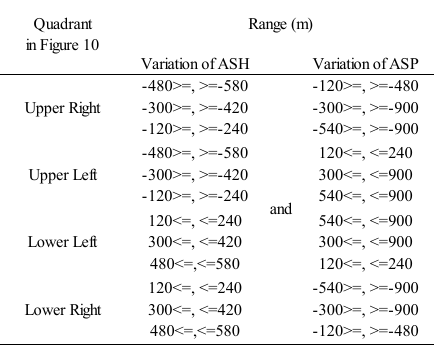
Table 1 . Range of variations in Figure 10 in order to define the 4 types of the spatial variations for the examination of relationship between the spatial features and the elderly